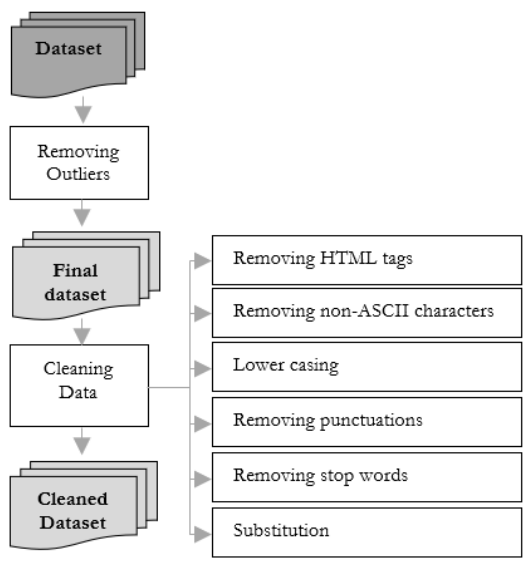
Figure 4. Overall cleaning process.